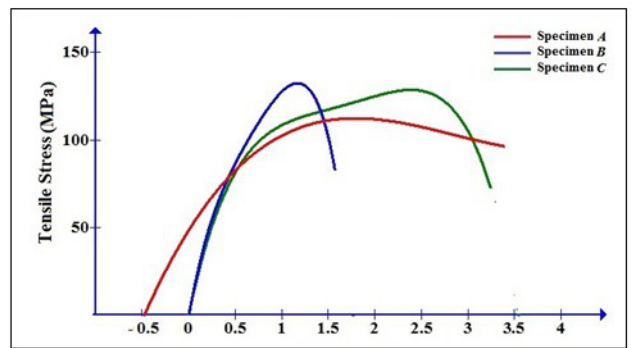
Figure 1. Stress-strain curve for specimens A , B , and C .